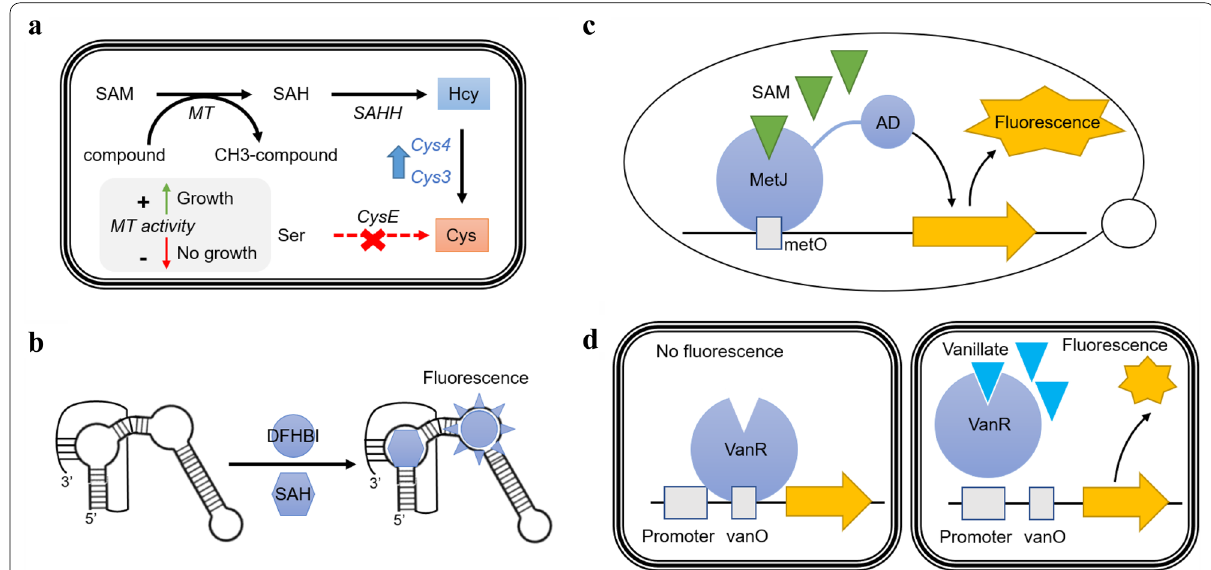
Fig. 5 Illustrations of in vivo high-throughput methyltransferases assays. a Growth-coupled methyltransferase assay, where the essential amino acid cysteine (Cys) biosynthesis is linked to SAH biosynthesis. SAH concentration is dependent on methyltransferase activity. If methyltransferase activity is present, Cys will be produced and there is rapid microbial growth. If methyltransferase activity is absent, Cys will not be produced, and no microbial growth is observed. b SAH riboswitch-based biosensor which will bind to 3,5-difluoro-4-hydroxybenzylidene imidazolinone (DFHBI) in the presence of SAH and produce fluorescence signal. c MetJ-MetO system as a biosensor to quantify intracellular SAM concentration in S. cerevisiae. MetJ is fused with an activating domain (AD). In the presence of SAM, metJ will bind to metO and AD will activate the downstream reporter protein expression. d VanR-VanO system as a biosensor to quantify vanillate concentration. In the absence of vanillate, VanR binds to VanO and blocks transcription. In the presence of vanillate, VanR will not be able to bind to VanO, and downstream reporter gene transcription will proceed.